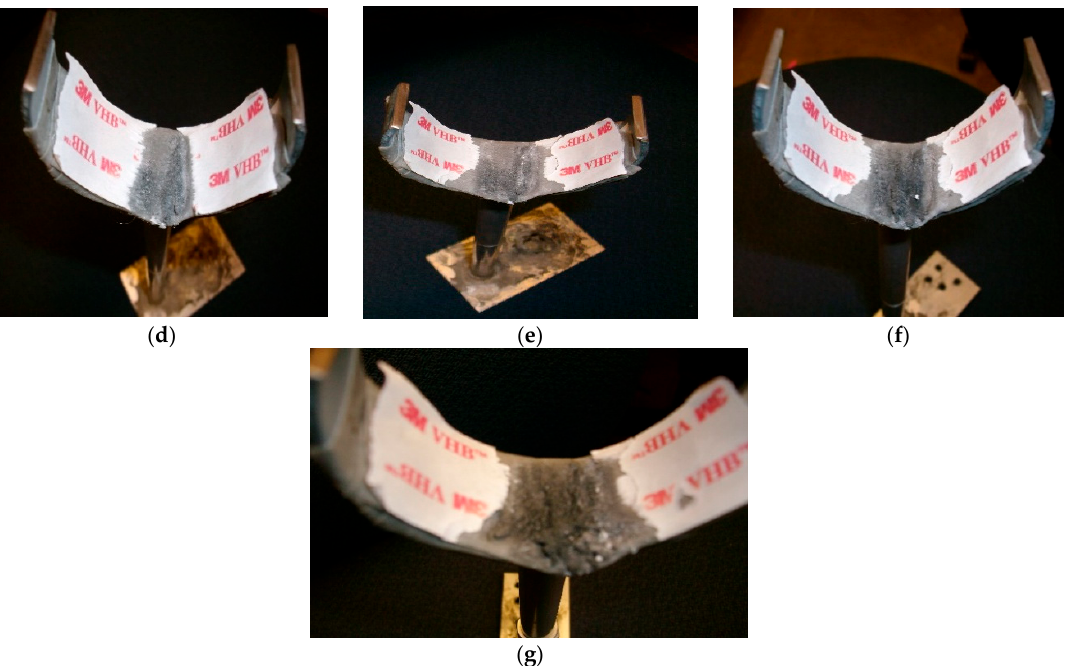
Figure 3. Surface of the sample after cyclic impacts: ( a ) after 10,000 cycles; ( b ) after 50,000 cycles; ( c ) after 100,000 cycles; ( d ) after 150,000 cycles; ( e ) after 200,000 cycles; ( f ) after 250,000 cycles; ( g ) after 360,000 cycles.